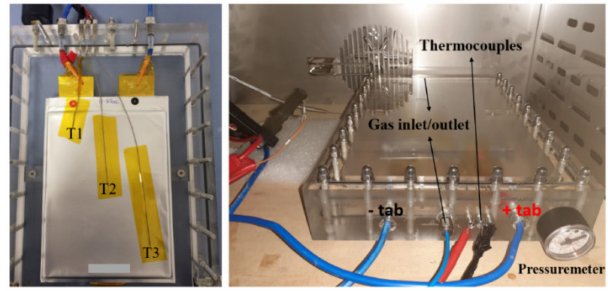
Figure 1. Experimental gas-based cooling